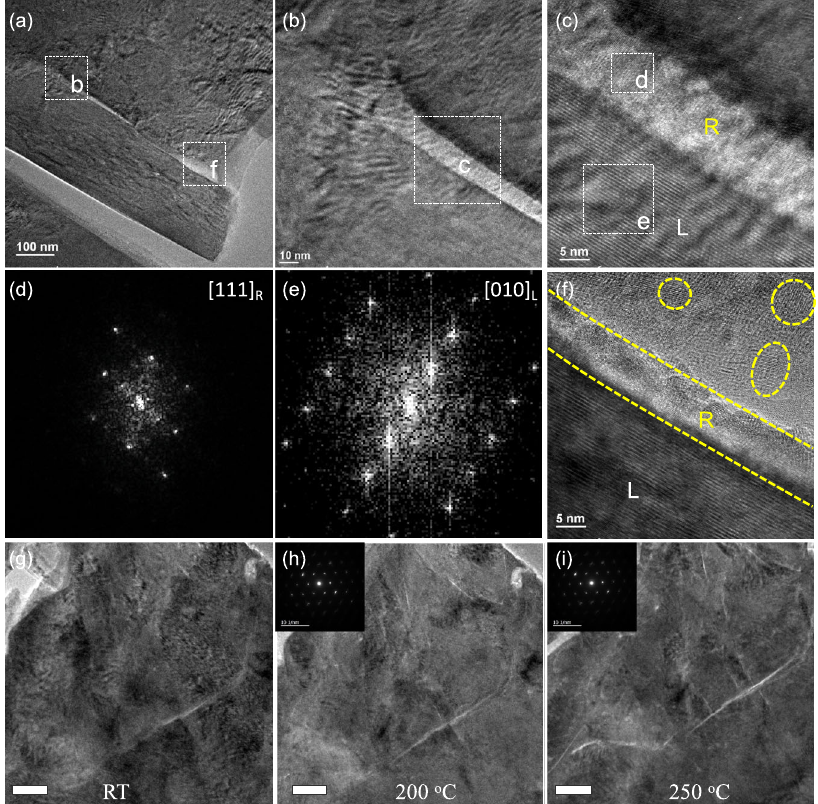
Fig. 6 TEM characterization on cycled O3 NaNi 0.4 Mn 0.4 Co 0.2 O 2 (2.0 – 3.8 V for 10 cycles). a Low magni fi cation TEM image. b Zoomed-in view of the dashed square area in a . c Zoomed-in view of the dashed square area in b . d , e Corresponding FFT patterns of the dashed square area in c . f HRTEM image of the dashed square area f in a . In situ TEM images of 3.8 V-charged O3 NaNi 0.4 Mn 0.4 Co 0.2 O 2 cathode during heating: g at room temperature; h at 200 °C and i at 250 °C. Insets of h and i are the corresponding SAED patterns. R and L represents the rock-salt and layered structure,